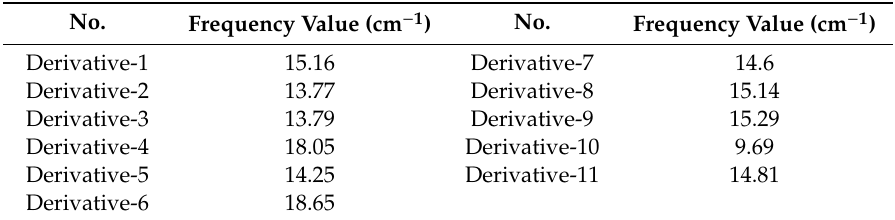
Table 4. Positive frequency calculations of quinolone